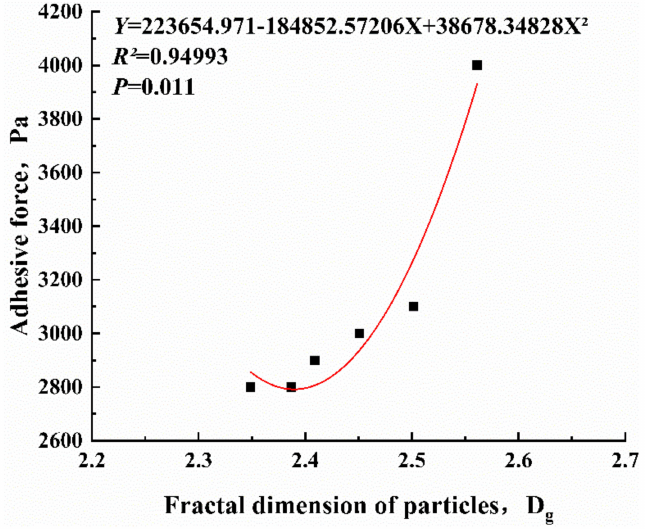
Figure 9. Analysis of the correlation between the fractal dimension and adhesive